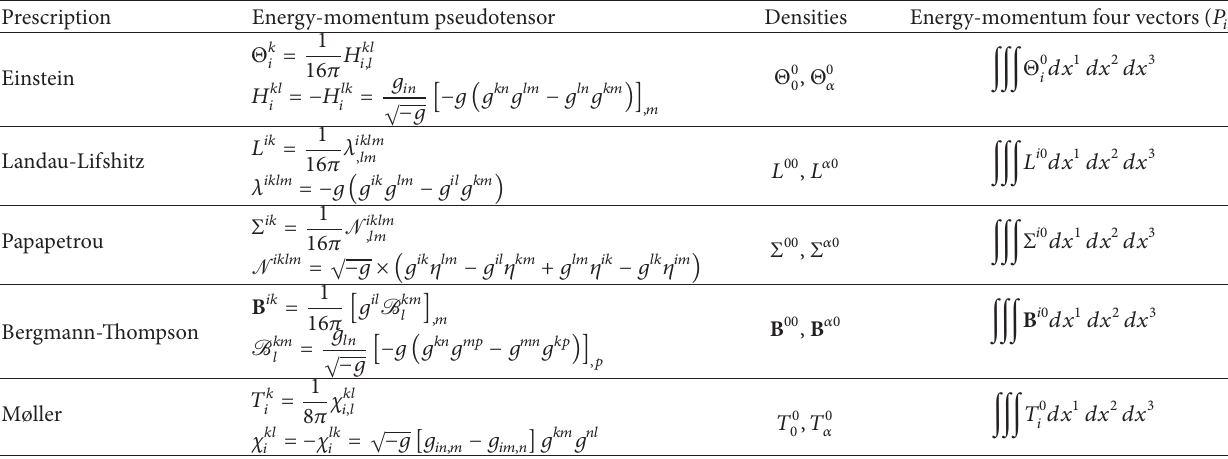
Table 1: Different energy-momentum prescriptions used in the present